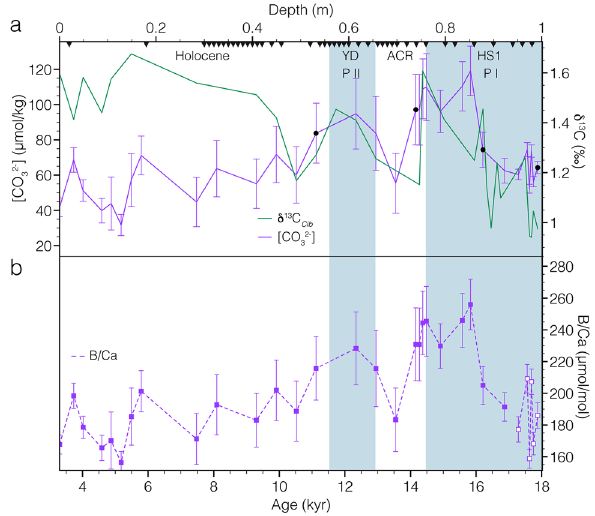
Figure 2. (a) δ 13 C (green) and carbonate ion data [CO 32− ] (purple) of core PS75/104-1. Black dots indicate samples that might be affected by bioturbation. Black triangles—radiocarbon dates 8,13 . Error bars—1σ. (b) Uncalibrated B/Ca data of PS75/104-1. Filled symbols— C. wuellerstorfi ; empty symbols— C. dispars . Blue shading— HS1 Heinrich Stadial 1, YD Younger Dryas, ACR Antarctic Cold Reversal. P I/II—CO 2 pulses as shown in Fig.